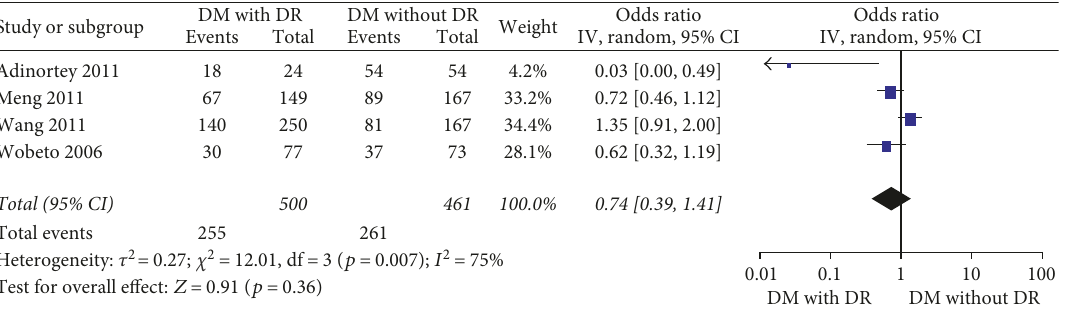
Figure 7: Forest plot for meta analysis comparing DR with DWR in additive model (TT+ CC versus CT).